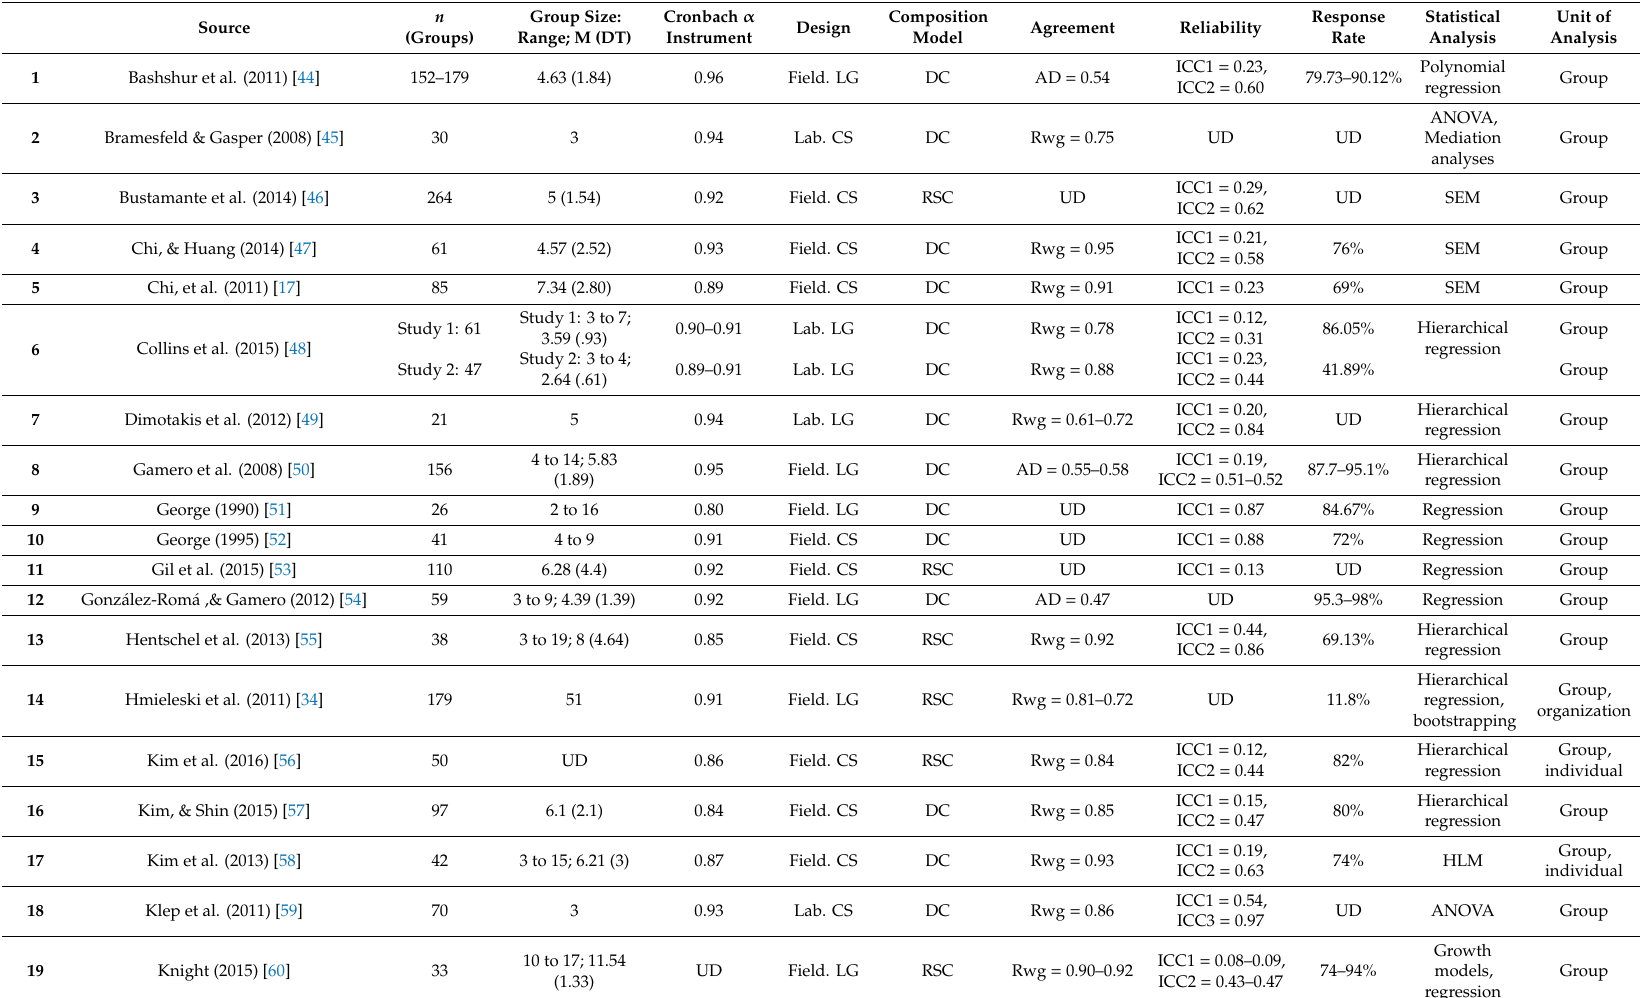
Table 1. Methodological characteristics of the included